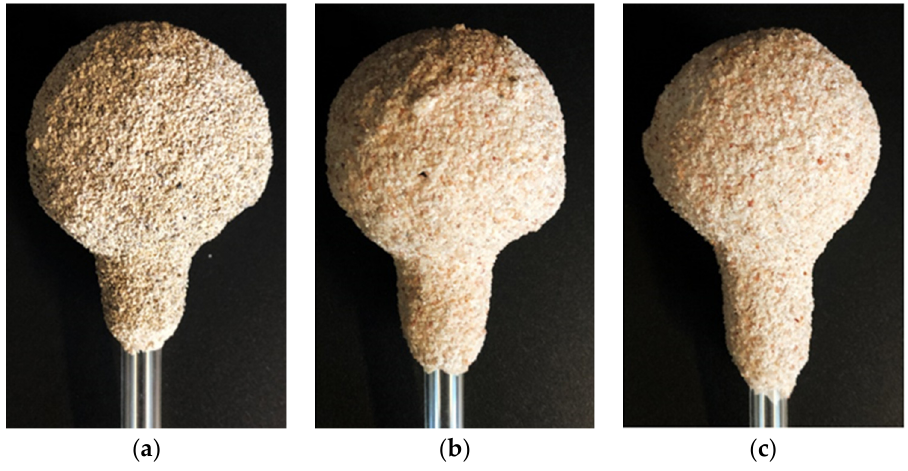
Figure 3. Samples of the ceramic molds: M1 ( a ), M2 ( b ) and M3 ( c ).